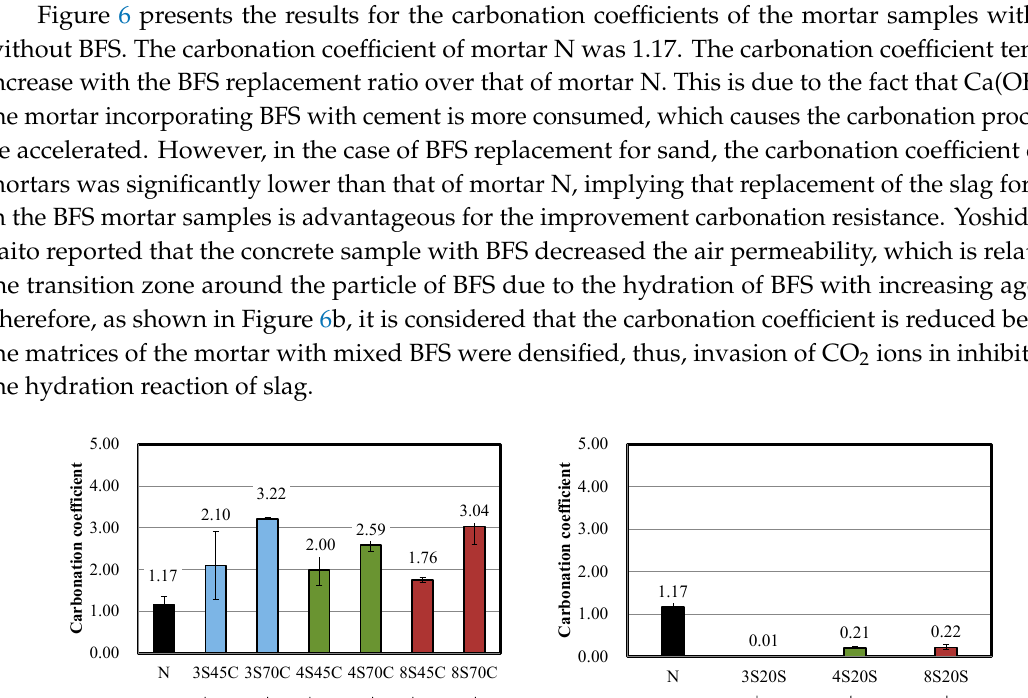
Figure 5. Durability factors for different mortar mixtures with or without BFS during freeze–thaw cycles: ( a ) replacement by BFS for cement and ( b ) replacement by BFS for sand.